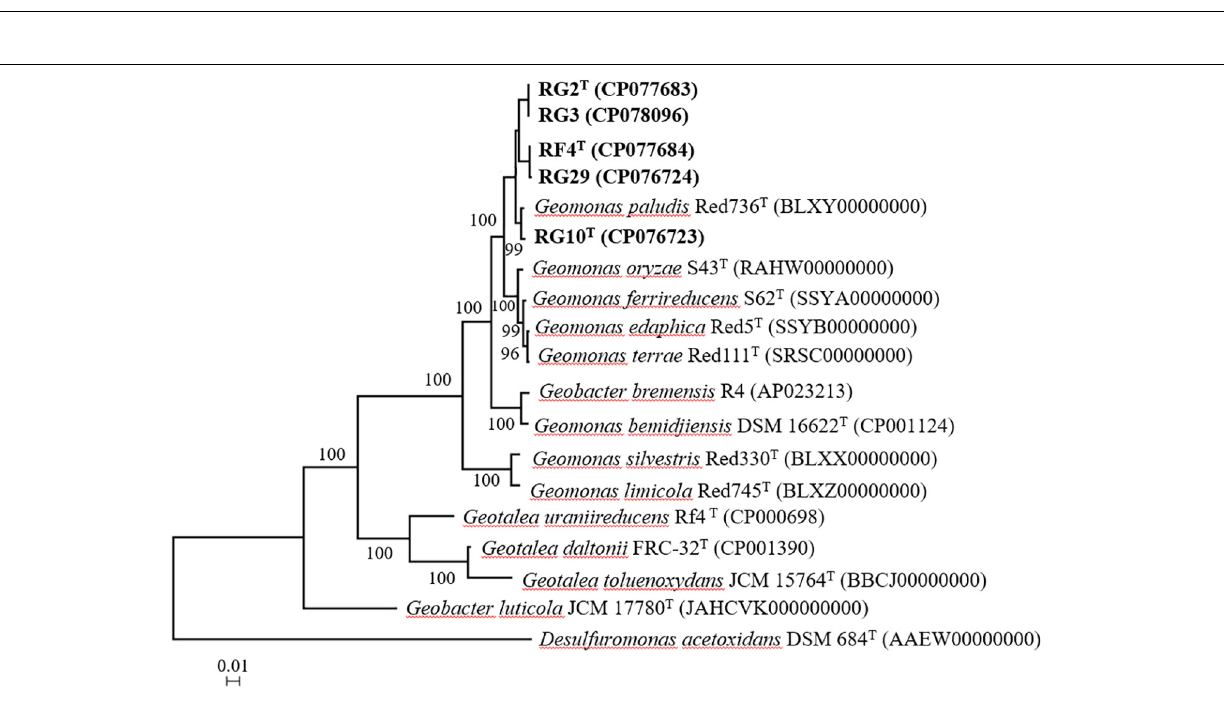
Frontiers in Microbiology |